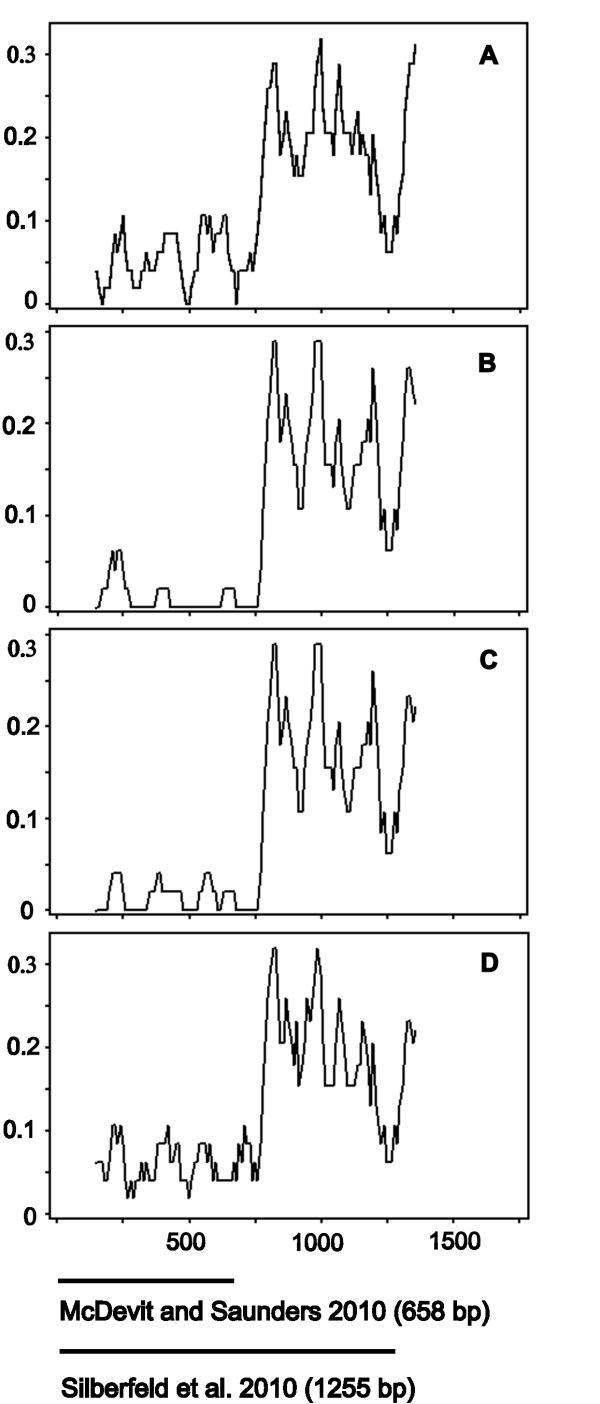
Sliding-window plots of divergence along the COI gene region between S. latissima and other laminarialean algae: S. japonica (A), the SHA form (B), S. coriacea (C), and S. angustata (D).  Window sizes are 50 nucleotides with ten-nucleotide increments. The thick black lines at the bottom mark the COI regions investigated by McDevit and Saunders [43] and Silberfeld with colleagues [2].